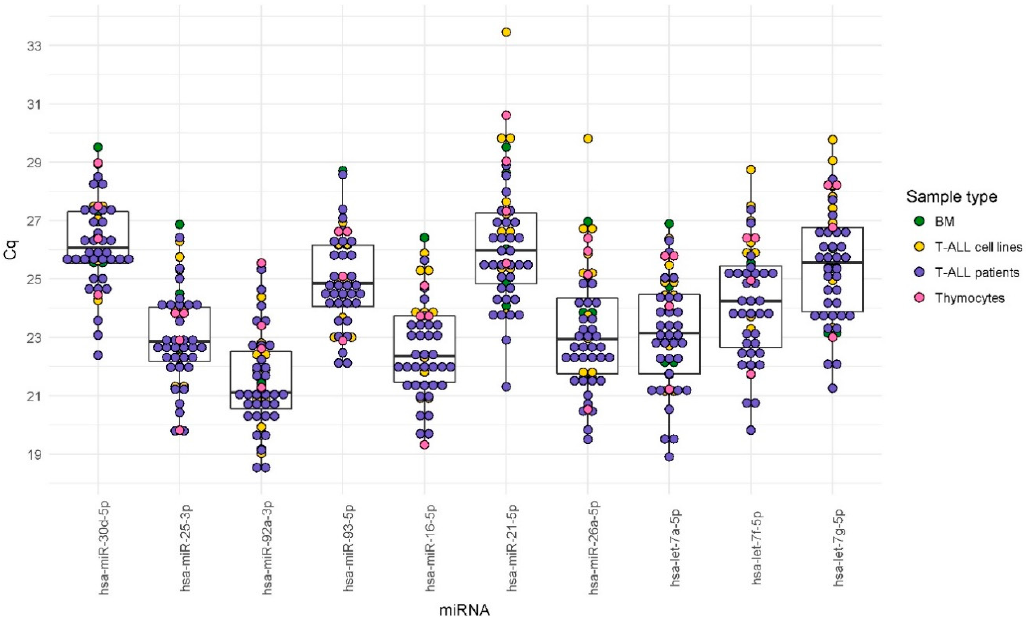
Figure 3. Overview of Cq values obtained by RT-qPCR for all samples with respect to the type of sample. BM, mature T-lymphocytes from normal bone marrow; thymocytes, normal precursors of T-cells. Dots represent mean raw Cq values for technical replicates of individual samples. Boxes correspond to the interquartile range (IQR) for each miRNA. Lines inside boxes indicate median Cq values. Candidate endogenous control miRNAs are ranked from left to right, according to increasing IQR value.